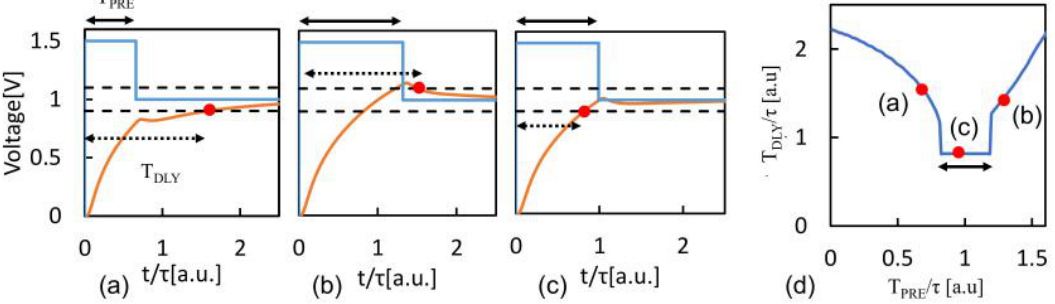
Figure 2. WL behavior at N 2 with T PRE of 0.6 τ ( a ), 1.25 τ ( b ), and 0.9 τ ( c ), and T DLY vs. T PRE ( d